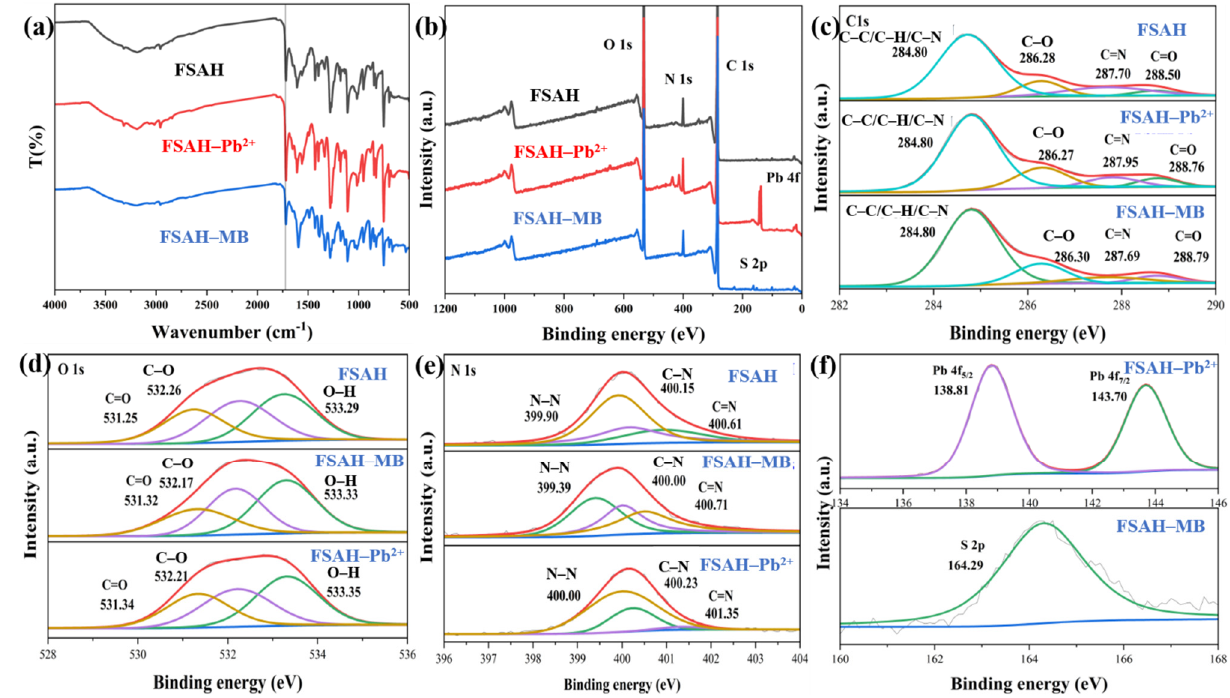
Figure 9. FT ‒ IR ( a ) and XPS ( b ) analysis of the FSAH, and XPS analysis ( c , d ) of C 1s, O 1s, and N 1s ( e ) of the FSAH before and after adsorption of Pb 2+ and MB, XPS analysis of Pb 4f and S 2p ( f ), respectively.